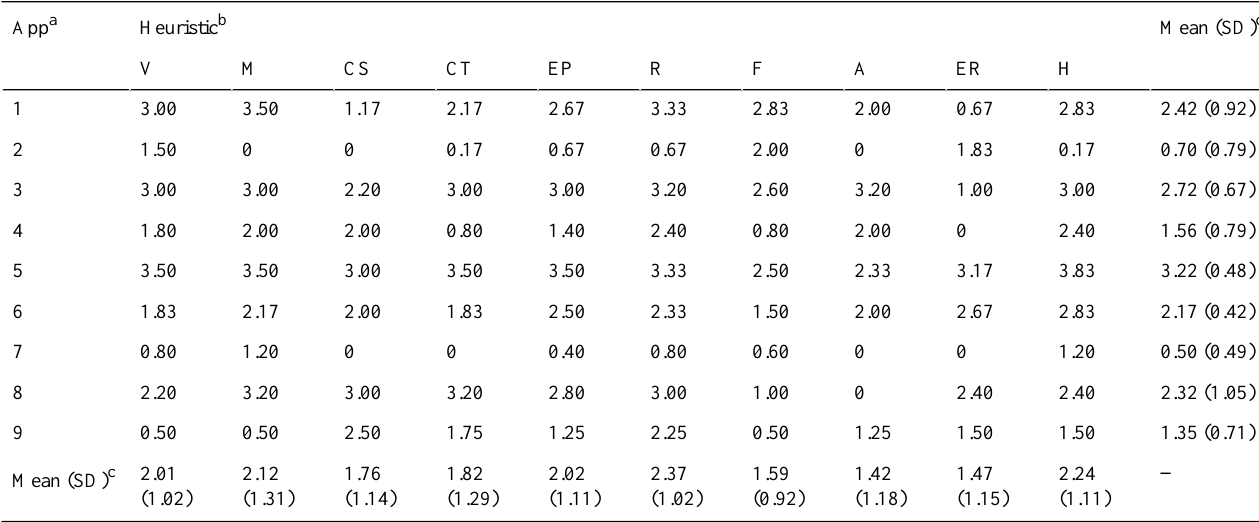
Table 2. Average usability heuristic scores across apps.